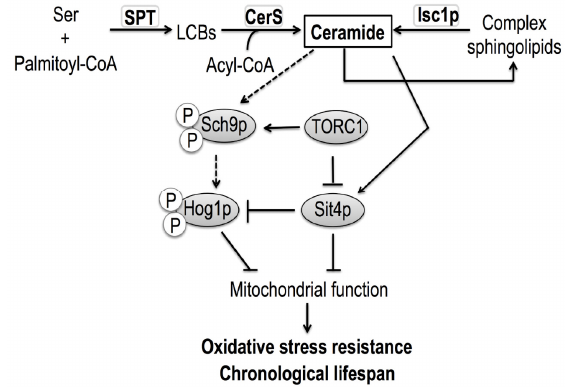
FIGURE 7: Sit4p and Sch9p integrate nutrient and stress signaling from TORC1 with ceramide signals to regulate mitochondrial function and CLS in yeast. Cells lacking Isc1p present increased TORC1-Sch9p activity, ultimately leading to mitochondrial dys- function, decreased oxidative stress resistance and shortened CLS. Apart from sensing signals from TORC1, the ceramide activated protein phosphatase Sit4p and the AGC protein kinase Sch9p also integrate ceramide signaling derived from Isc1p to regulate mito- chondrial function, oxidative stress resistance and chronological lifespan in